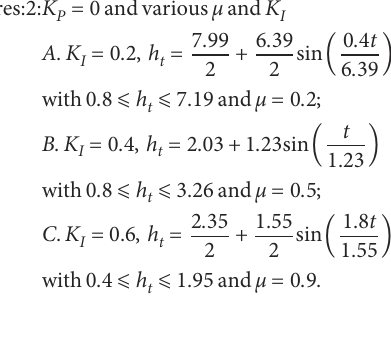
TABLE 5 MADUBs h 2 forvarious μ > 0andvarious h 1 undertheorem